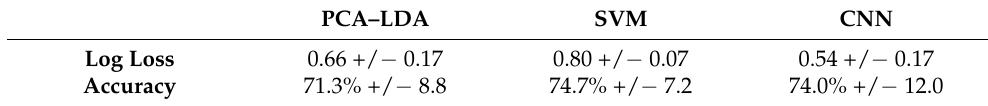
Table 2. Three class models: mean log loss and accuracy across all folds +/ − 1 standard deviation.